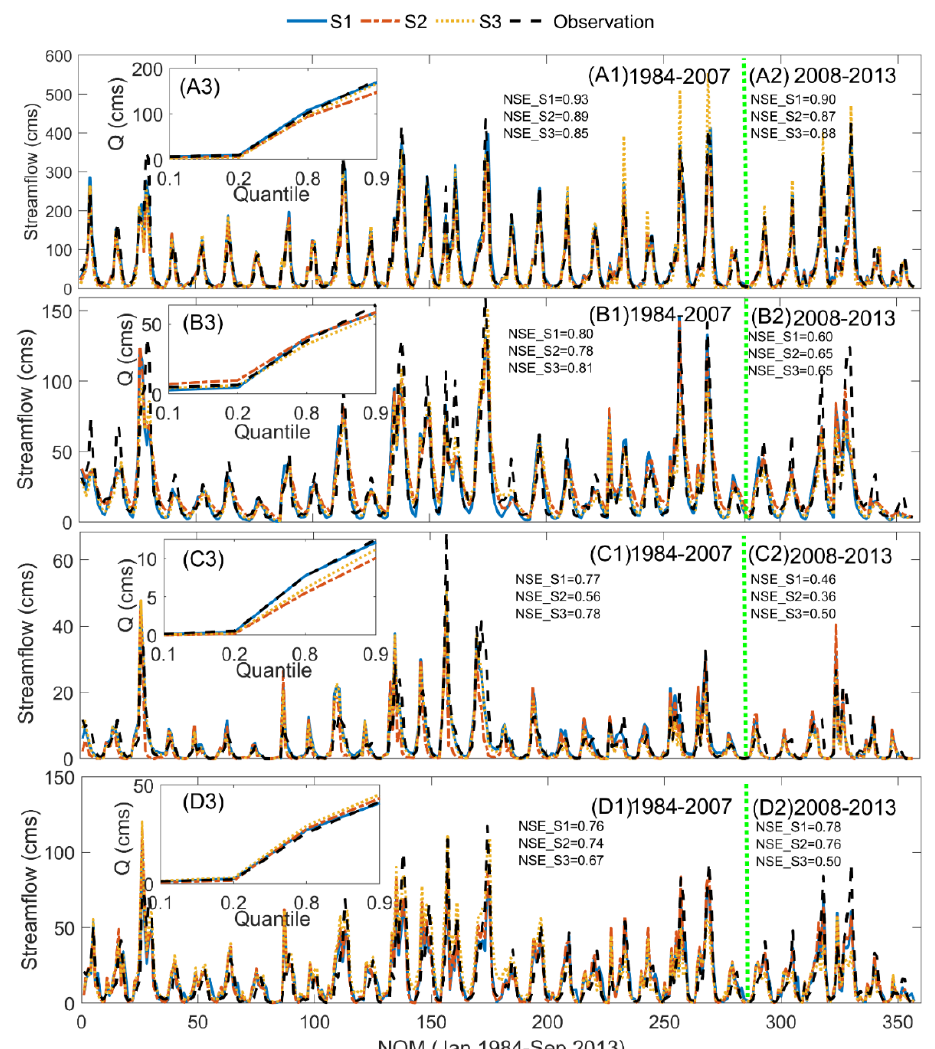
Figure 3. Predicted streamflow for the calibration (1984–2007) and validation (2008–2013) periods for the three calibration scenarios. Results are shown for the Kings ( A ), Kern ( B ), Tule ( C ), and Kaweah ( D ) Rivers. The green dotted line indicates the end of the calibration period and the beginning of the validation period. Inserts show a comparison of the three calibration scenarios for the selected flow quantiles (10%, 20%, 80%, and 90%, respectively). NSE refers to the Nash-Sutcliffe Efficiency, and S1–S3 refers to Scenario 1–Scenario 3. NOM: number of months.